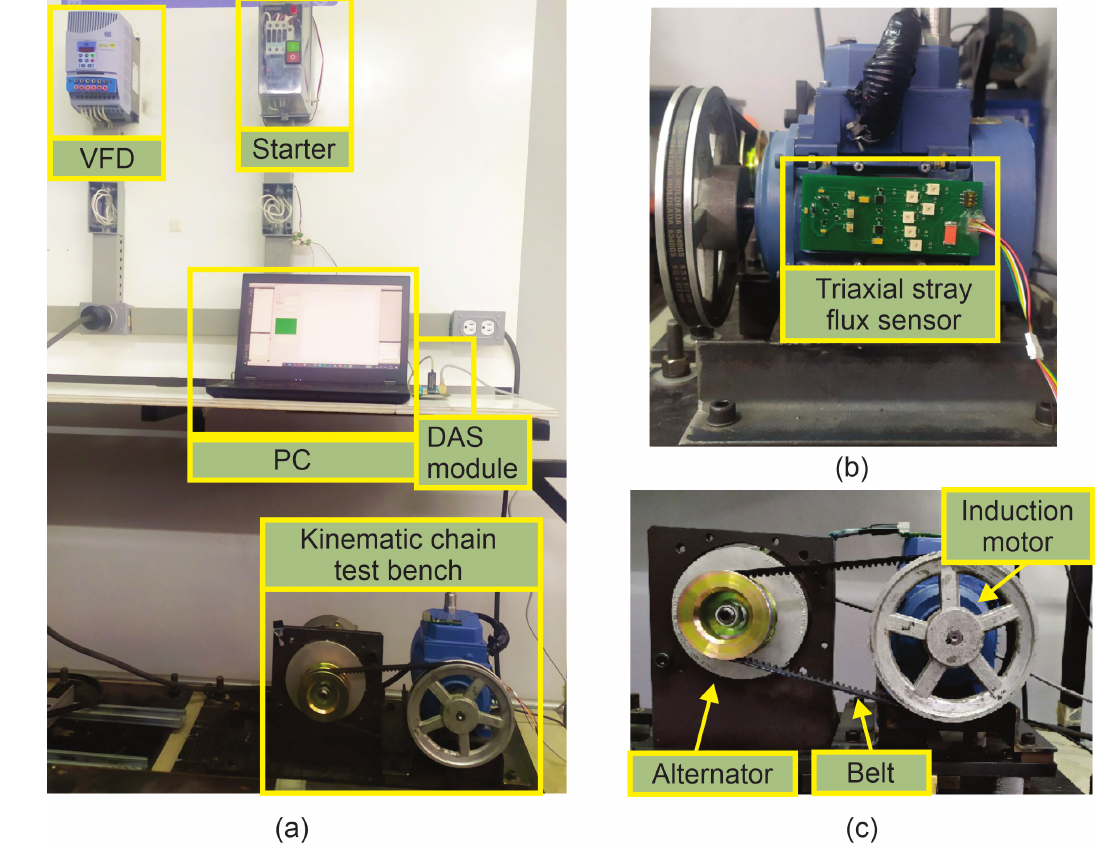
Figure 4. Experimental setup: ( a ) Kinematic chain test bench. ( b ) Side view of the test bench. ( c ) Front view of the testbench. Table 2. Test matrix for all study